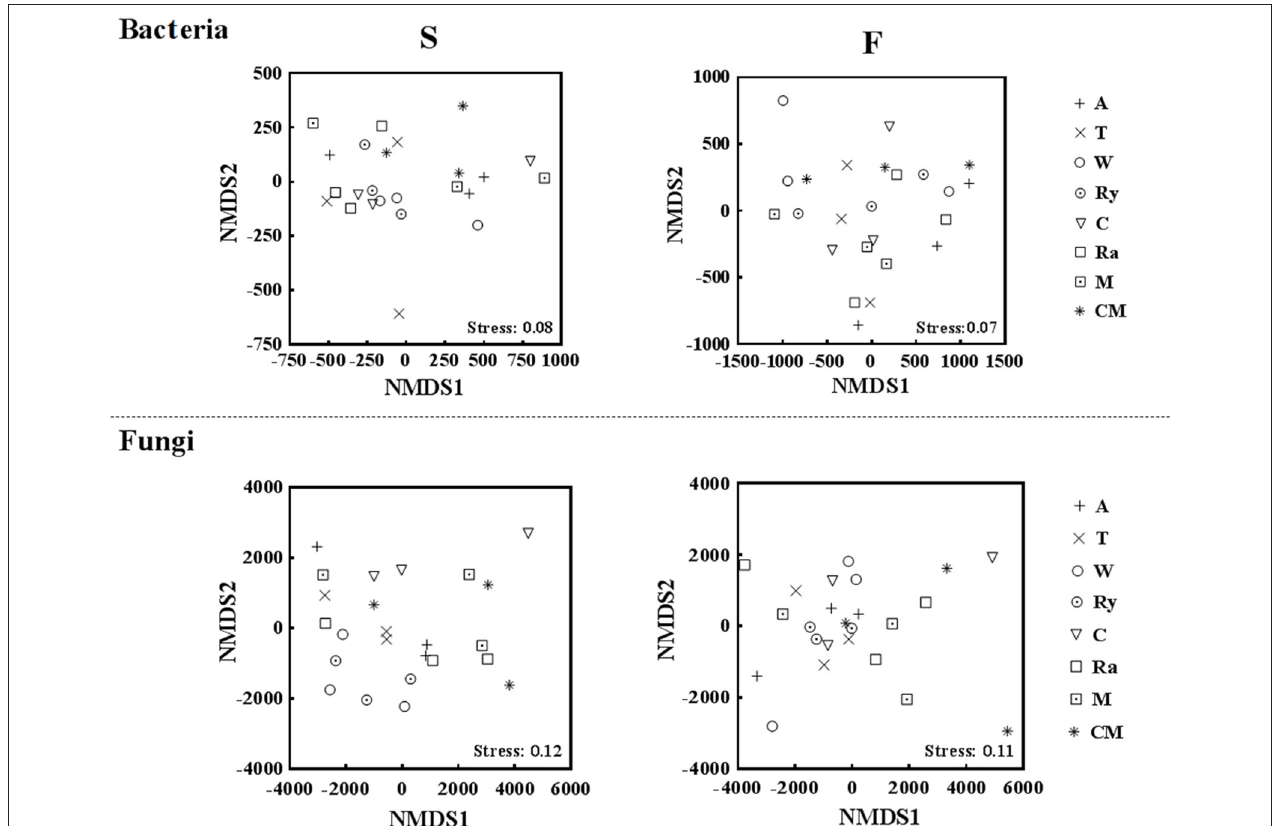
FIGURE 4 | Nonmetric multidimensional scaling (NMDS) based on euclidean distance plot of all soil bacterial and fungal communities in the spring (S) and fall (F) cropping seasons.